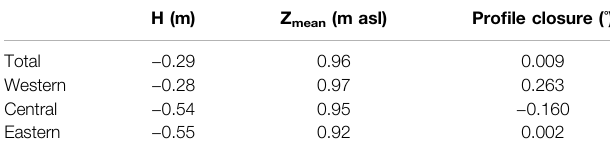
TABLE 3 | Pearson ′ s r between CFA and used factors in the study